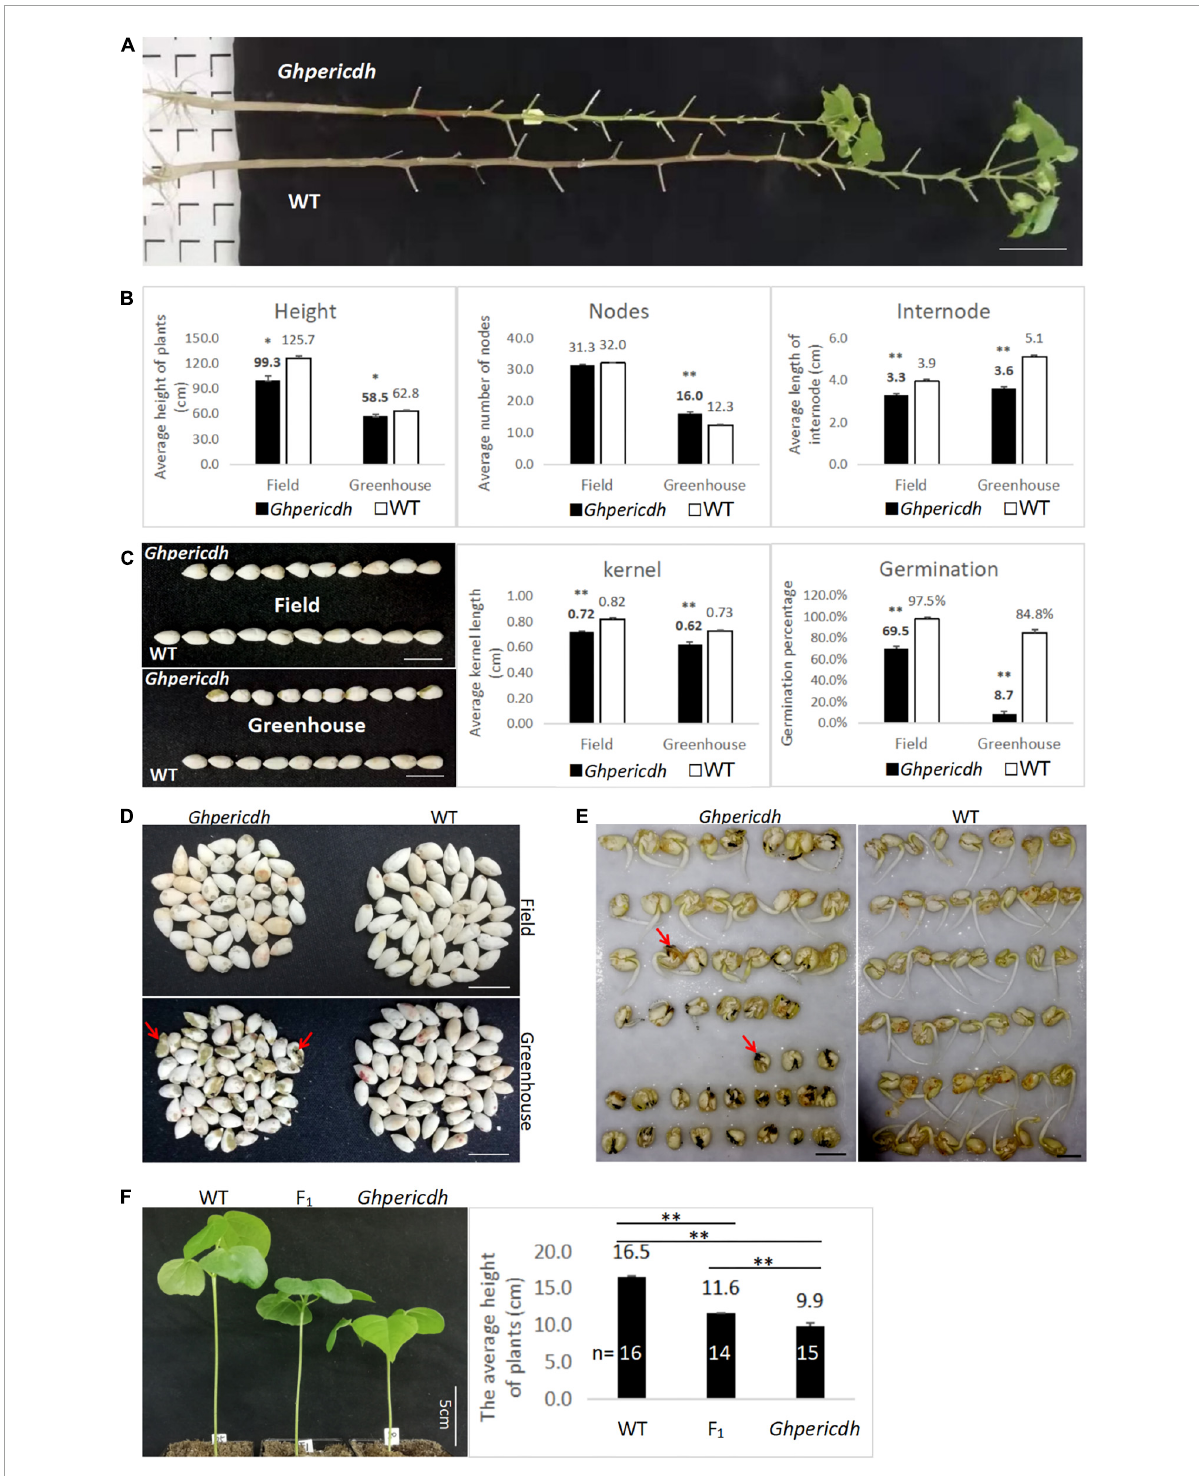
FIGURE3 Phenotypic characteristics of Ghpericdh . (A) Plants growing for 5 months in the field. Scale bar = 10 cm. (B) Comparison of plant height, node number, and internode length between genotypes in the field for 5-month growing and in the greenhouse for 3 months cultured. (C) The kernel length and the germination rate of seeds harvested from the field and the greenhouse. Scale bar = 1 cm. (D) The kernel characteristics harvested in different locations. Scale bar = 1 cm. (E) Comparison of greenhouse-seed germination between genotypes. Scale bar = 1 cm. (F) Seedling morphology (the left) and average plant height (the right) of F 1 . ∗ p < 0.05, ∗∗ p <